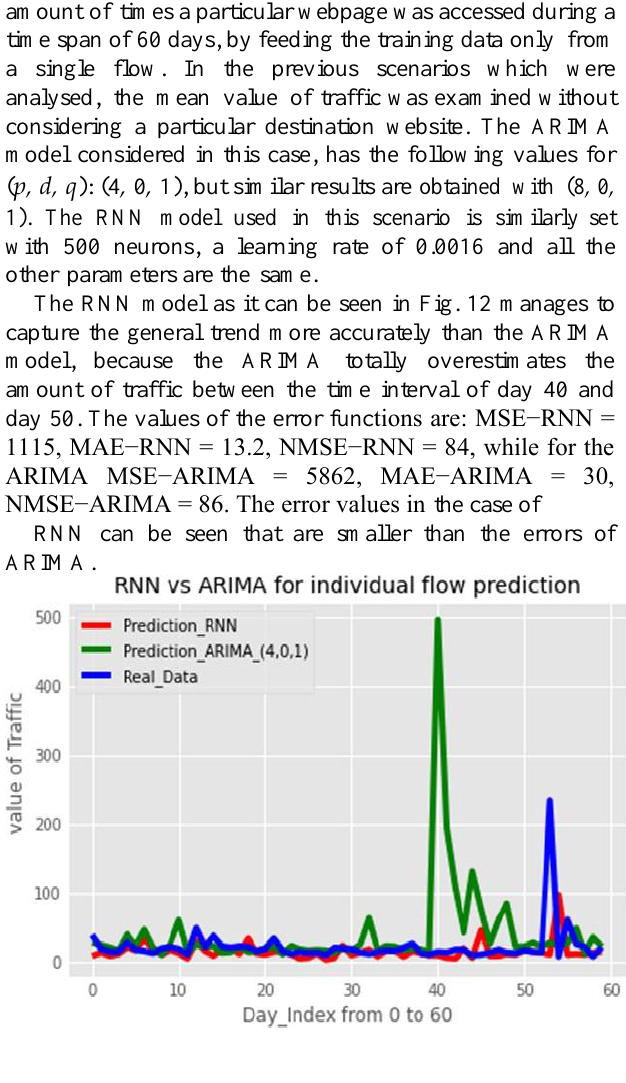
Figure 10. RNN predictor and AdaBoost predictor for 300 training samples.